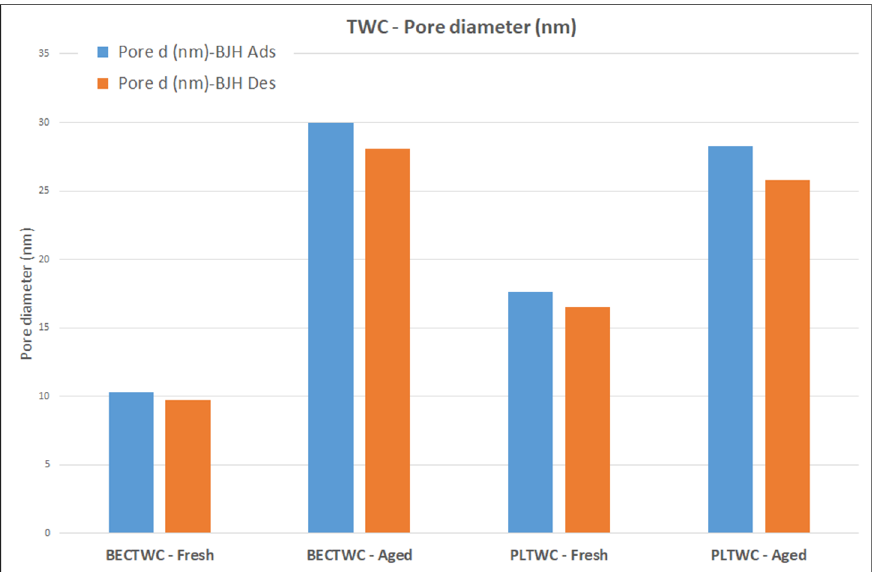
Figure 3. Pore Diameters—BJH Method: BECTWC, PLTWC.